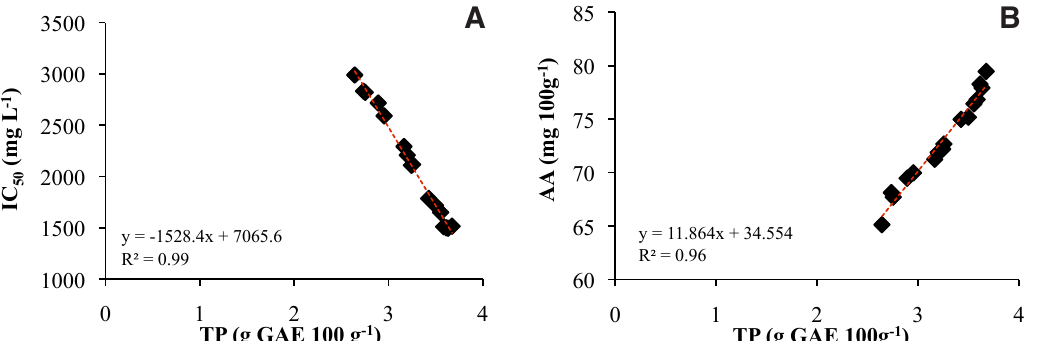
Fig. 3: Correlations between (A) total phenolics (TP) content and antioxidant activity (IC 50 ) and (B) between total phenolics and ascorbic acid (AA) content in Portulaca oleracea